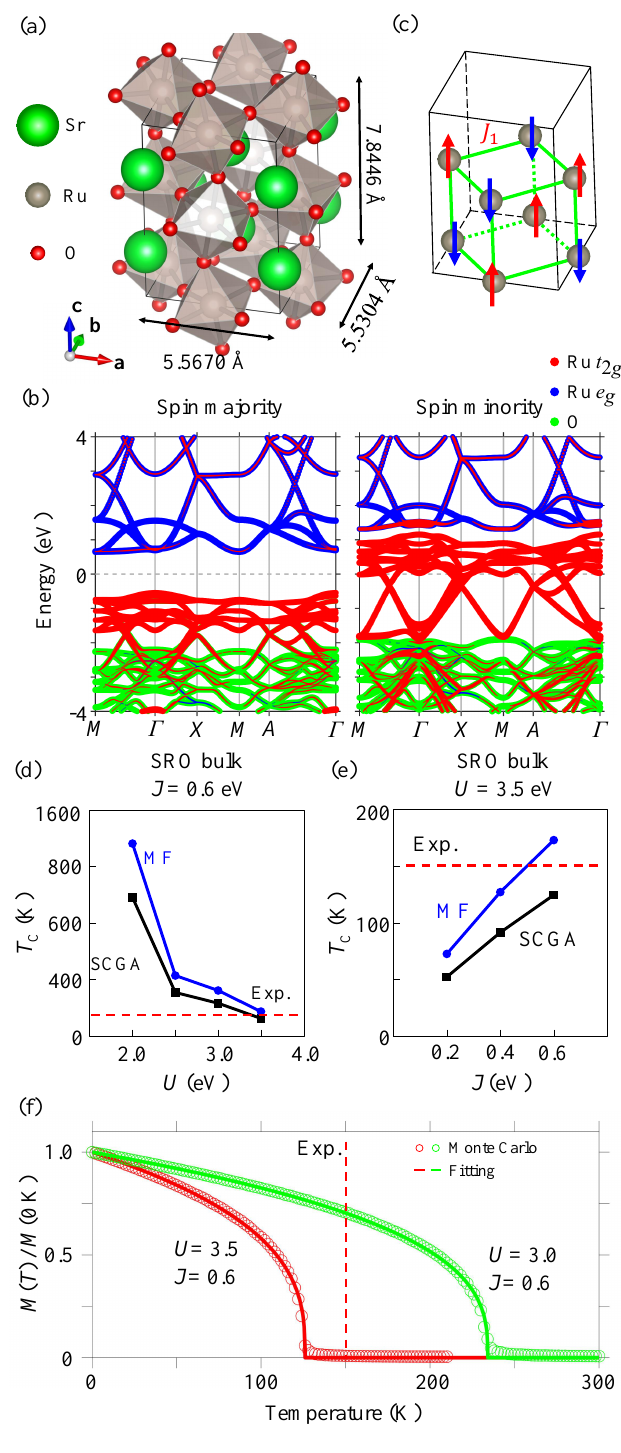
Figure 1. ( a ) The crystal structure of SrRuO 3 . ( b ) Calculated band structures of SRO from LDA + U. The colors indicate different orbital components. ( c ) The G-type antiferromagnetism spin configuration of SRO. ( d ) The mean field and SCGA. ( e ) Curie temperatures of bulk SRO with different U and J . The experimental Tc is shown in red dashed line. ( f ) The Monte Carlo simulations of Curie temperatures. The colors indicate different U and J . The lines are the fitted curves for the data points given from Monte Carlo simulations. The red dashed line indicate the experiment